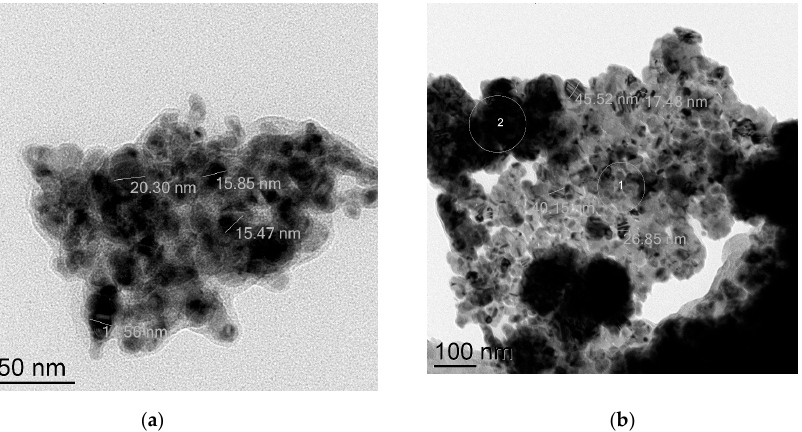
Figure 1. TEM images of CuNPs of the average particles size 25 nm: ( a ) 16 nm nanoparticles; ( b ) 35–52 nm nanoparticles.